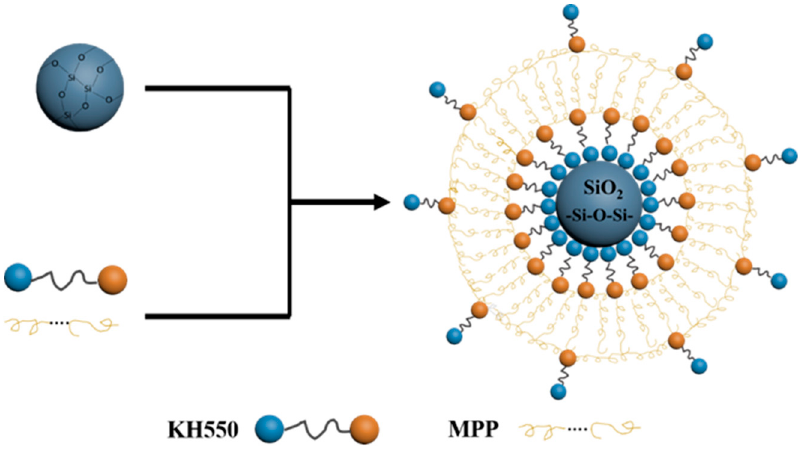
Figure 3. The structural representation of SiO 2 /MPP modifier.